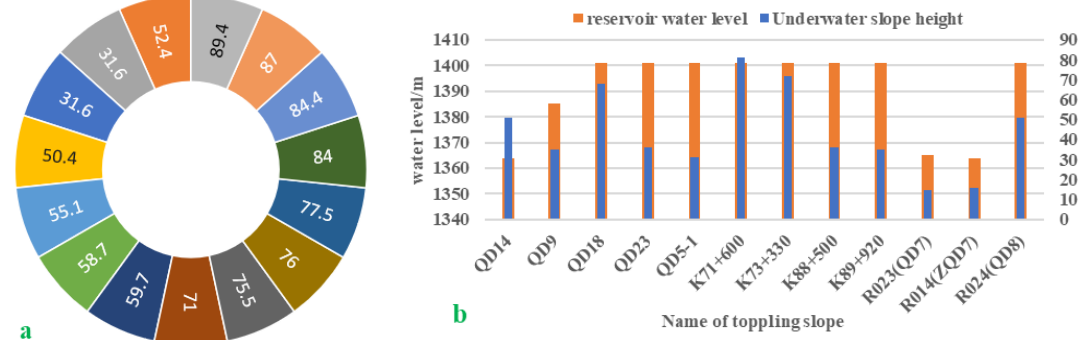
Figure 6. ( a ) Water depth on the front of the slope with toppling failure. ( b ) The relationship between the water depth in front of the slope and the quantity of toppling failure.